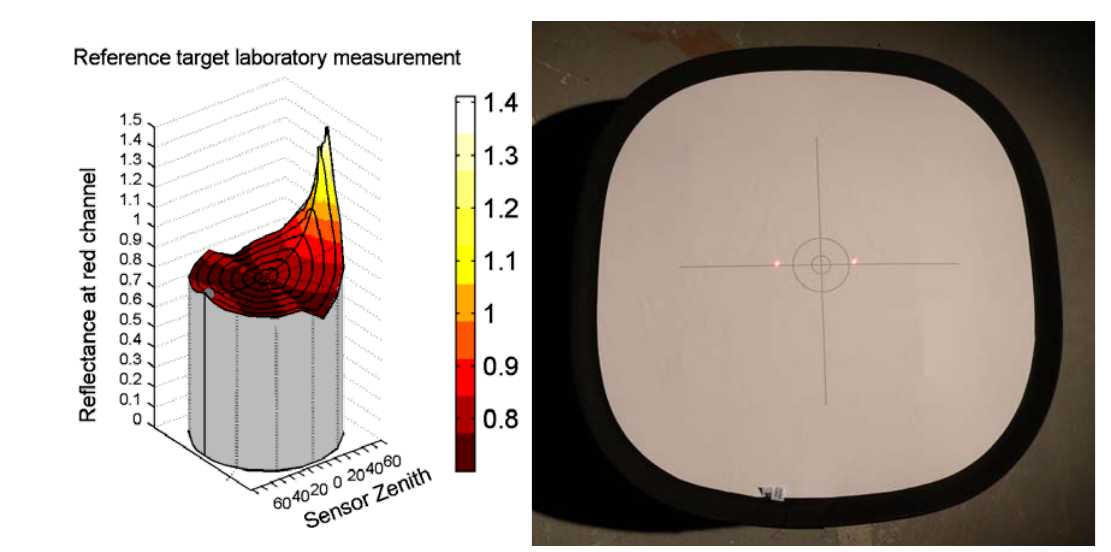
Figure 4. Left: High specular reflectance can be observed in the reference target laboratory measurement BRF. Right: A picture of the reference target during the laboratory measurement. The two red laser dots indicate the measurement